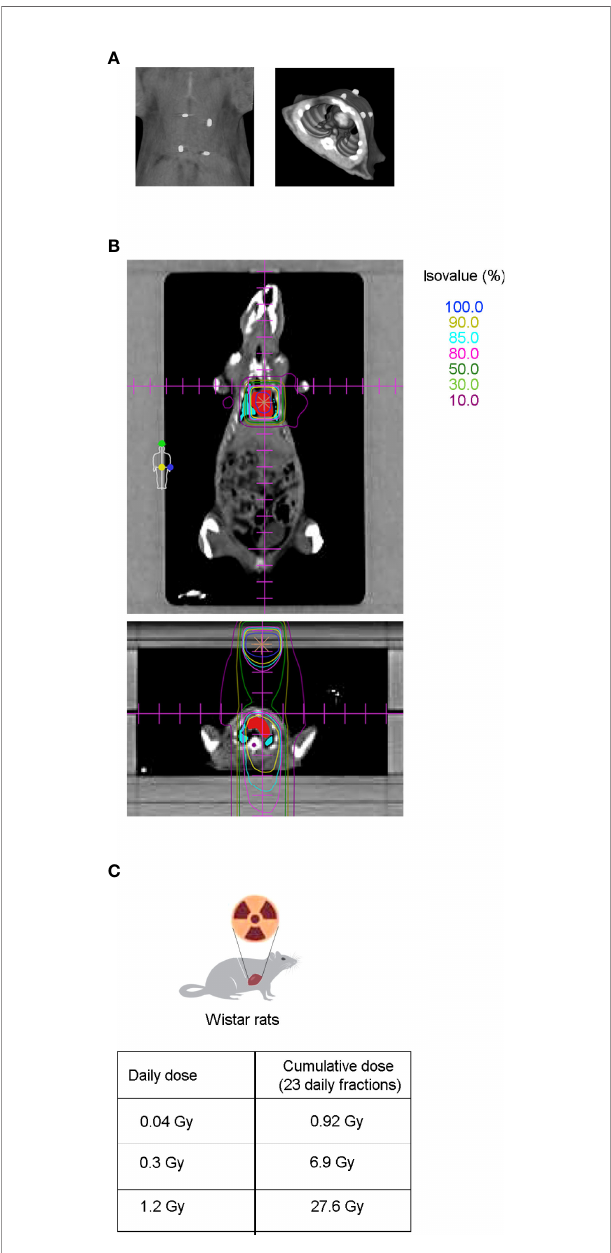
FIGURE 1 | CT simulation and dose distribution planning preceded thoracic radiation therapy in Wistar rats. (A) After echocardiography, radiopaque fi ducial markers were placed over the shaved skin of the animal (left panel) to correlate the CT images to the external anatomical references used during animal setup prior to RT (right panel). (B) Coronal (upper panel) and axial view (lower panel) from CT-based radiation therapy planning dose distribution. Isodose curves are shown in a range of 100% (dark blue), to 10% (dark pink), being the most internal ones: 90% (yellow), 85% (light blue) and 80% (light pink), for the prescribed doses of 0.04, 0.3, and 1.2 Gy. Target heart structures (red) and organs at risk such as the lungs (blue) and medulla (purple) are also shown. (C) Twelve to fourteen week old Wistar rats were cumulatively irradiated with 0.92, 6.9, or 27.6 Gy, administered in a fractionated scheme of 23 daily doses of 0.04, 0.3, or 1.2 Gy,